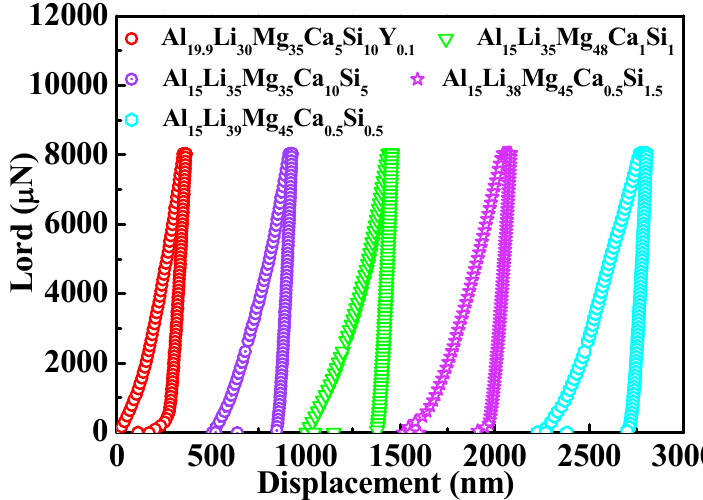
Figure 6. Representative load-displacement curve of nanoindentation tests for five ULW-CCAs.